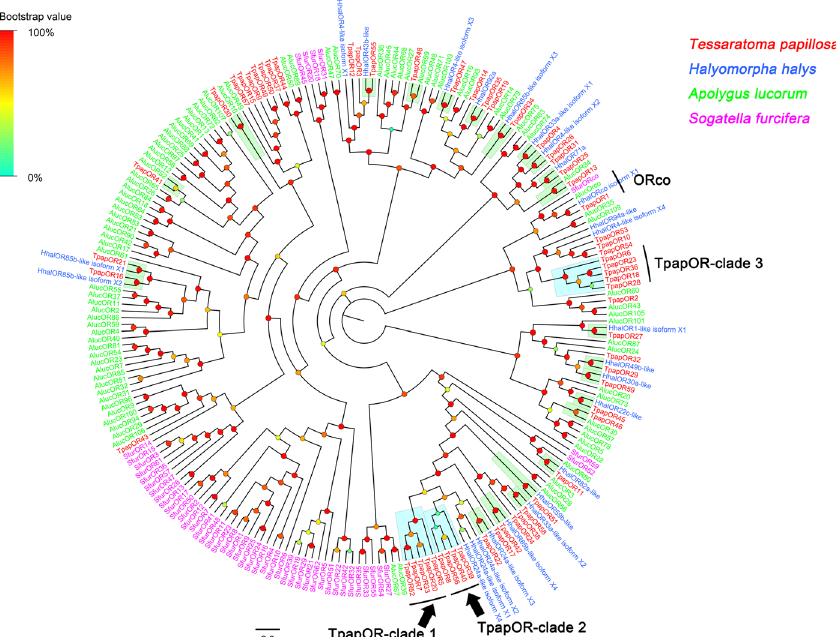
Figure 2. Phylogenetic analysis of putative T . papillosa ORs with other hemipteran ORs. The dendrogram was generated by FastTree2 (JTT substitution model). Species abbreviations: Tpap, Tessaratoma papillosa ; Aluc, Apolygus lucorum ; Hhal, Halyomorpha halys ; Sfur, Sogatella furcifera . Amino acid sequences used for tree construction are shown in Supplementary Table S2. Branch support (circles at the branch nodes) was estimated using an approximate likelihood ratio test based on the scale indicated at the top left. Bars indicate branch lengths in proportion to amino acid substitutions per